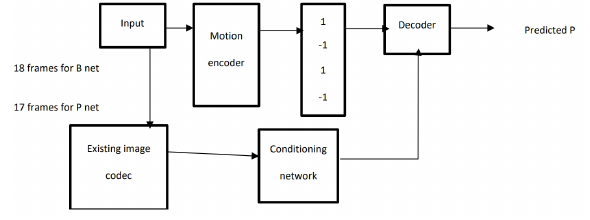
Fig. 2. Model of video prediction network. The